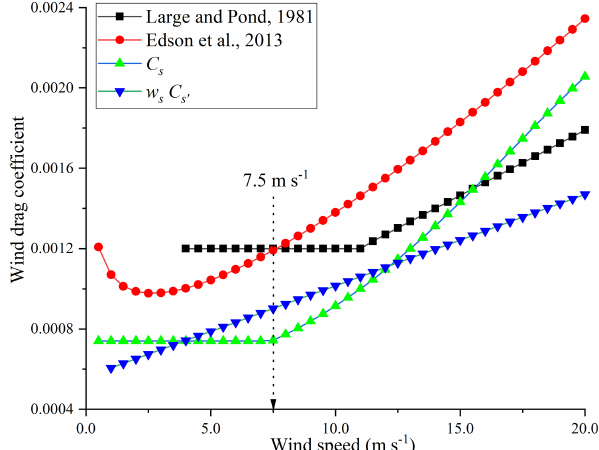
Figure 4. Changes in wind drag coefficient with wind speed calcu- lated by the equations proposed by Large and Pond (1981), Edson et al. (2013), C s and w s C s (cid:48)